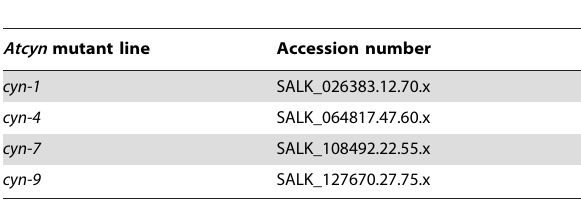
Table 4. Accession numbers of the Atcyn mutant